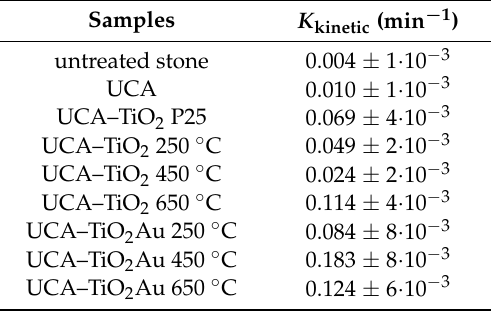
Table 4. Kinetic constants for the MB decoloration process of UCA–TiO 2 Au samples nanocomposites in comparison with UCA–TiO 2 calcinated at 250 ◦ C, 450 ◦ C and 650 ◦ C, respectively and UCA–TiO 2